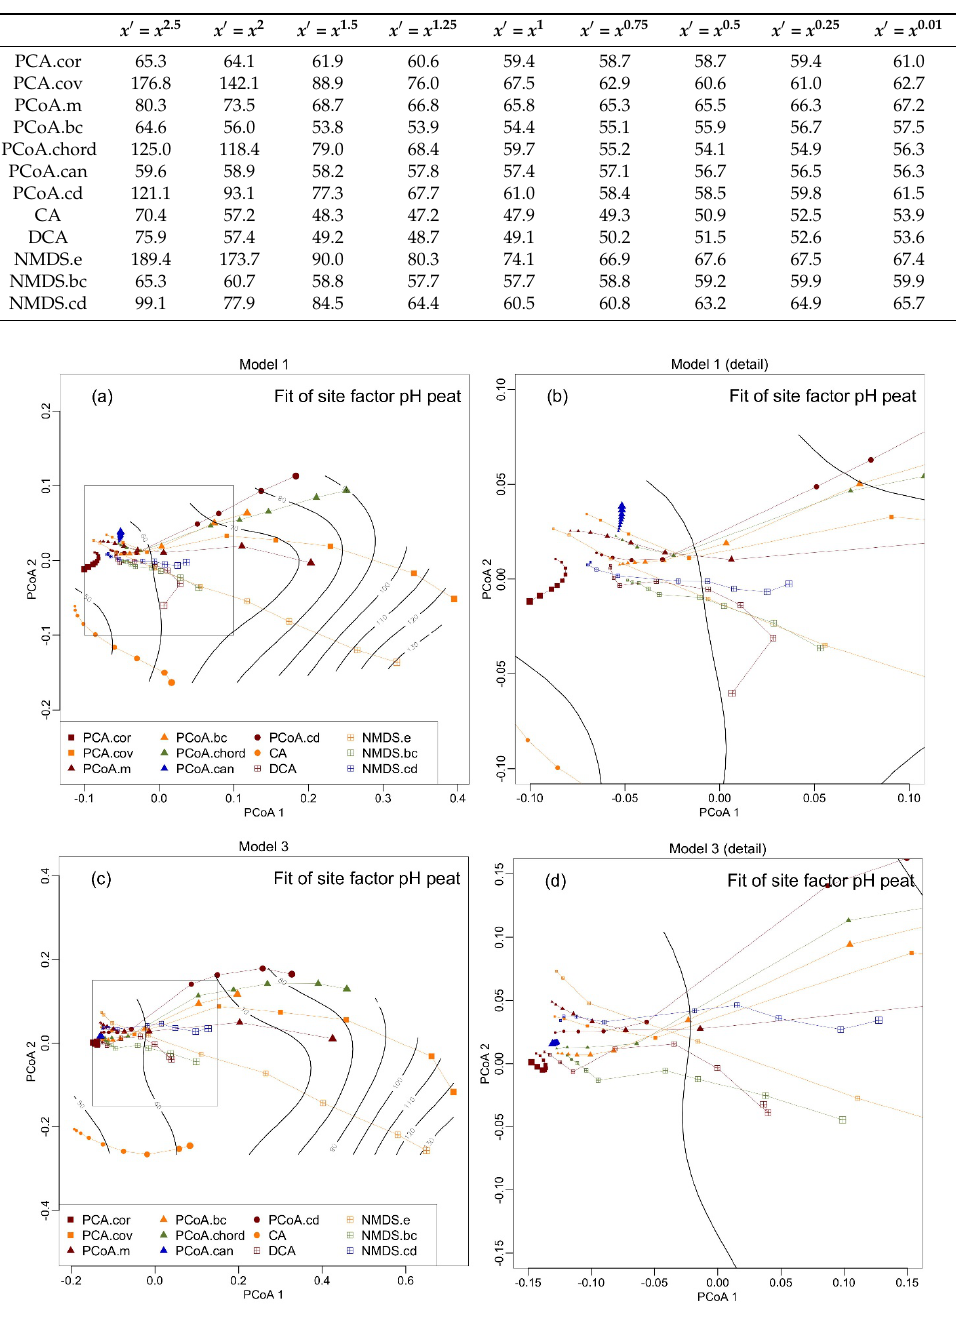
Table 2. The efficiency of ordinations of “sveg” data (Figure 1) measured by fitting trend surfaces of site factor “pH.peat” to the first two ordination axes. The elements of the table are Akaike’s criterion (AIC) values expressing residual deviations with a correction for degrees of freedom [27]. Extensions in the method names signify: “cor” for correlation-based, “cov” for covariance-based, “m” for using Manhattan distance, “e” for Euclidean distance, “bc” for Bray-Curtis distance, “chord” for chord distance, “can” for Canberra distance, and “cd” for correlation used as distance.